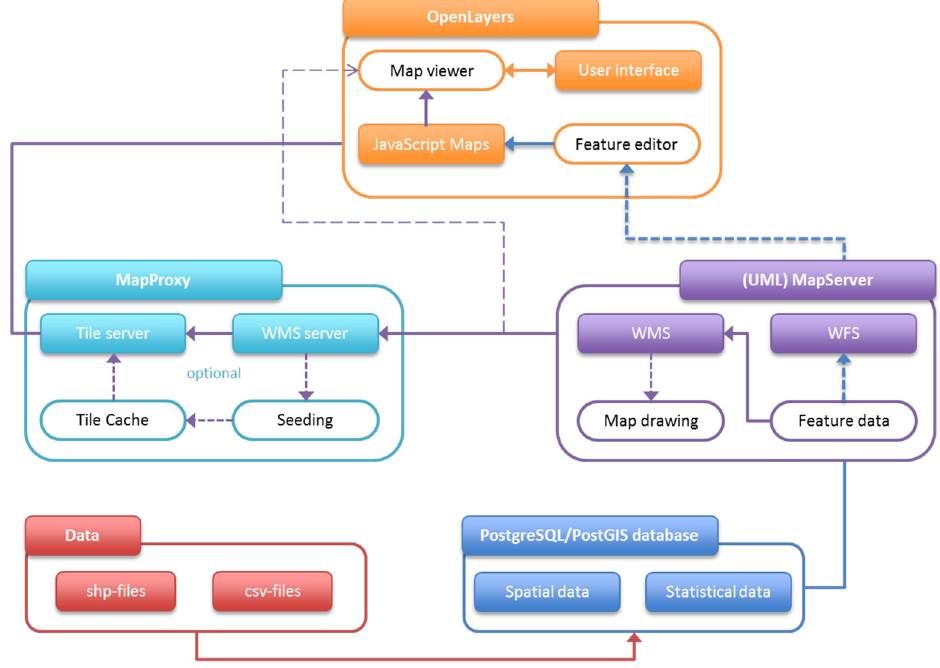
Figure 1. Applications Architecture of the spatial